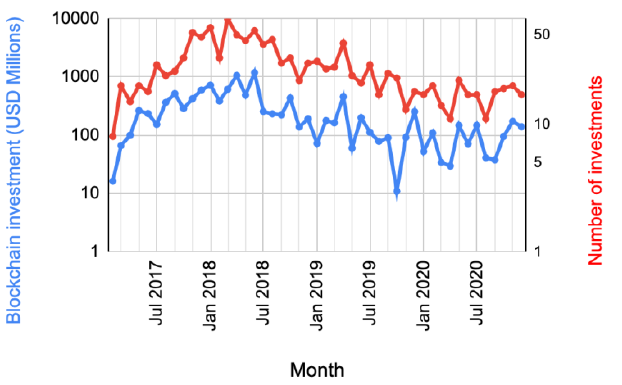
Figure 5: Investment raised (in USD) and number of investments made to Blockchain-related companies from Crunchbase.